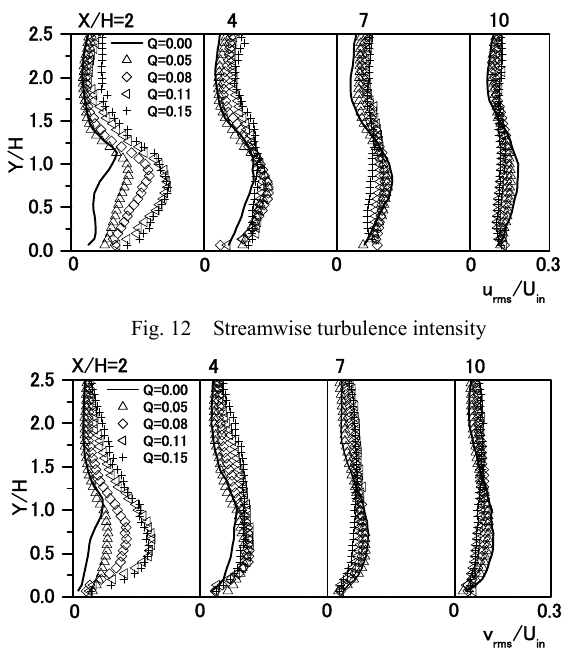
Fig. 13 Wall － normal turbulence